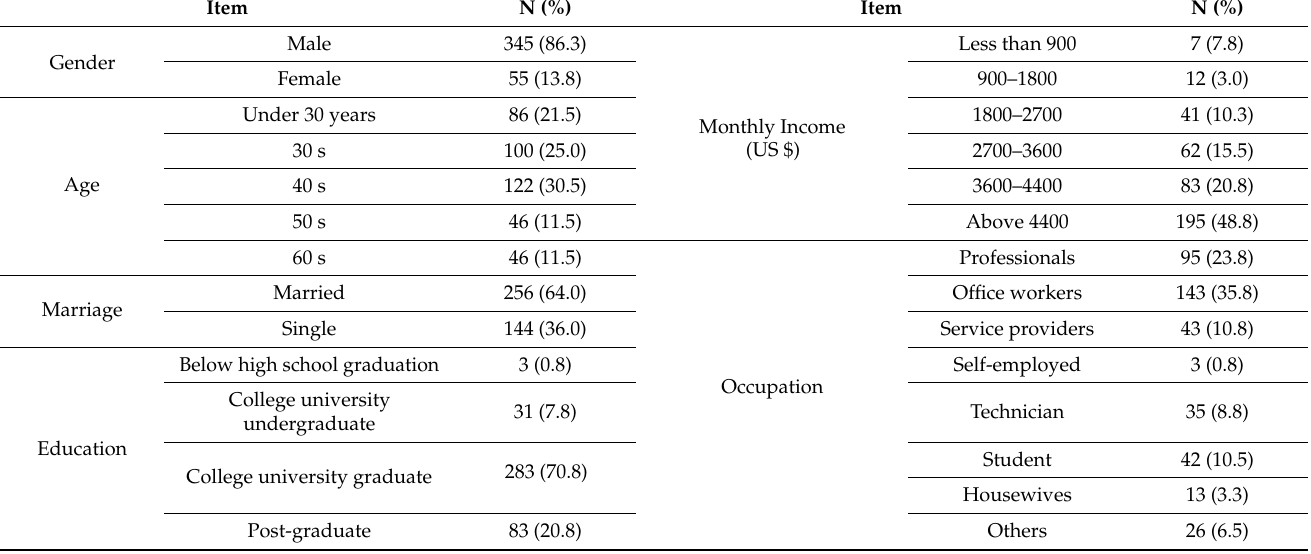
Table 1. Characteristics of the